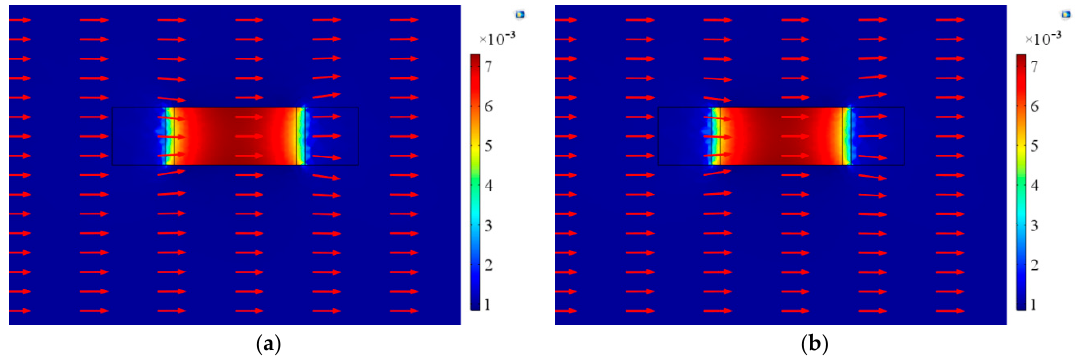
Figure 16. Magnetic flux distribution on ( a ) the upper and ( b ) lower surfaces of Terfenol-D under a uniform magnetic field.